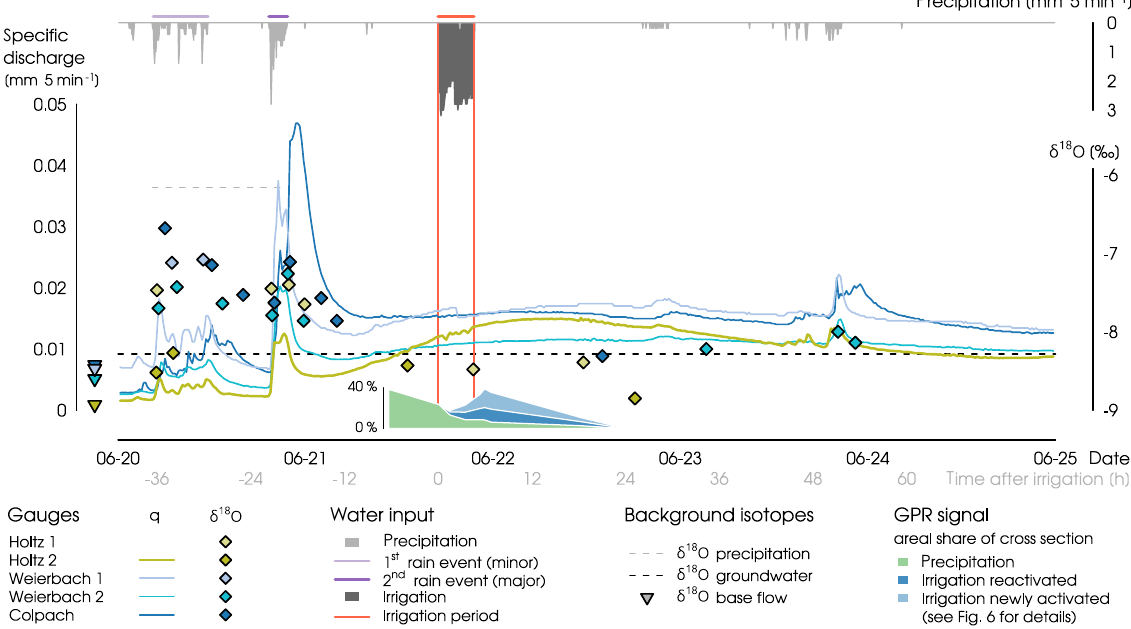
Figure 5. The figure shows the natural storm event on 20 June 2013 in the Colpach River catchment and the local intensity of the irrigation on 21 June 2013. The hydrographs below show the discharge response of four nested catchments (solid lines), in combination with the dynamics of the δ 18 O isotopic composition of the surface water (dots). The isotopic composition of the groundwater (annual mean) and the precipitation (daily values) are given by the dashed lines. Furthermore, the dynamic response of the GPR signal to natural and artificial rainfall is given in green and blue. While the first minor rain event caused only a weak response, the second event caused a double-peak discharge response in all sub-catchments. The irrigation experiment took place 19:22h after the rain